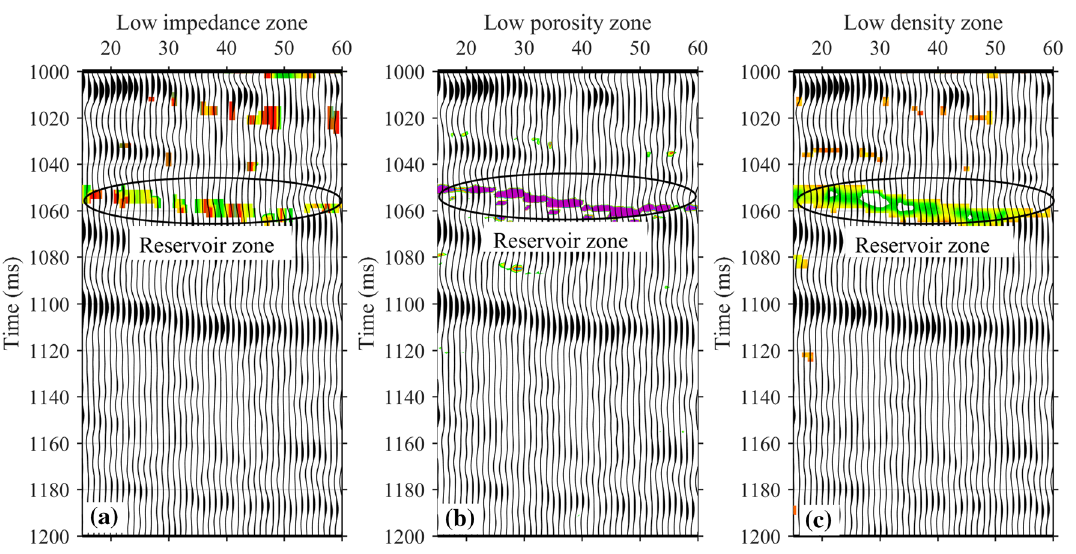
Fig. 14 Variation of a low impedance zone (< 9000 m/s*g/cc), b high porosity zone (> 15%), and c low density zone (< 2.35 g/cc) in the seismic section. These anomalies are corresponding to the reservoir